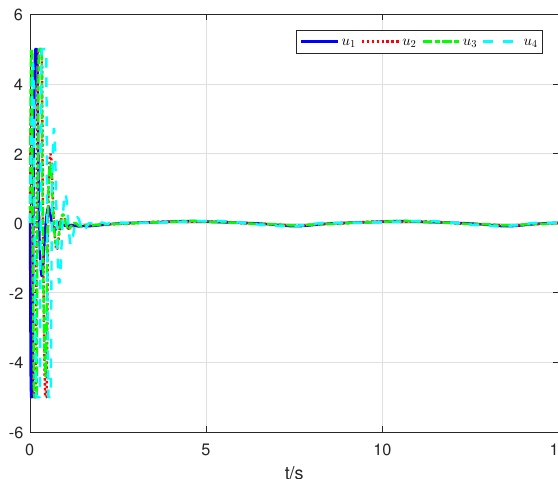
Figure 6. The trajectories of the control inputs u i .